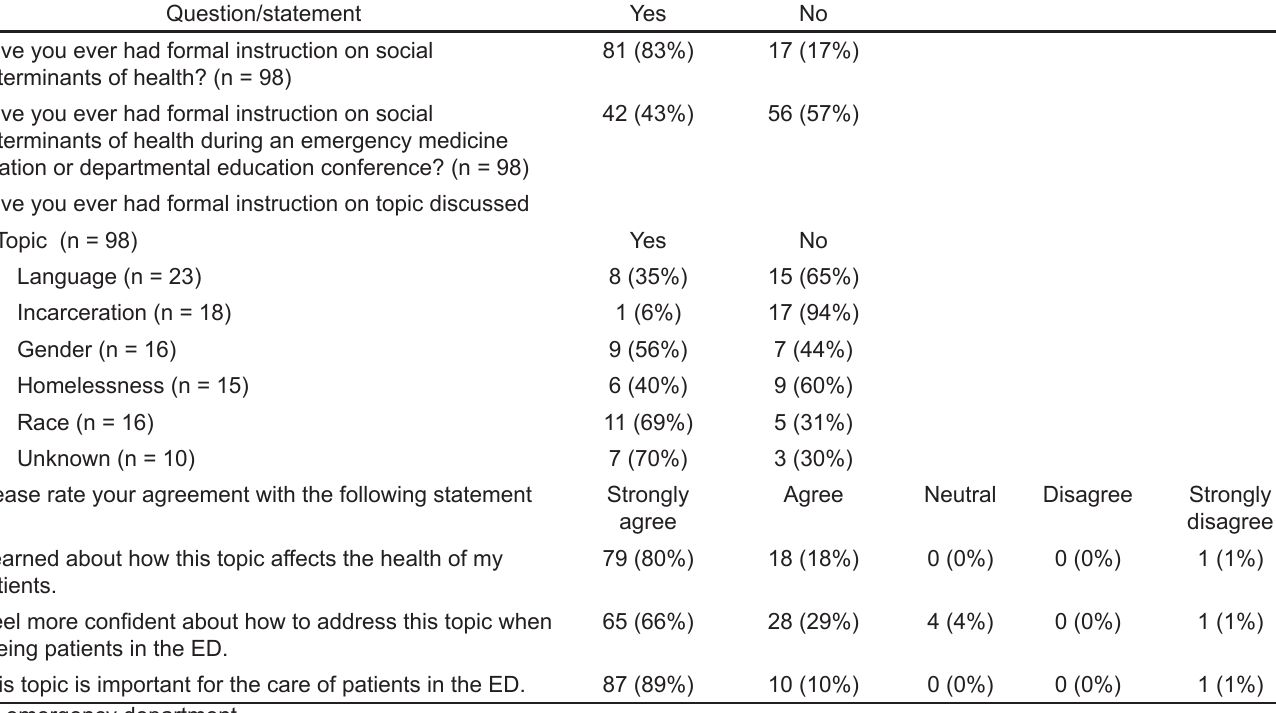
Table 2. International and Domestic Health Equity and Leadership sessions